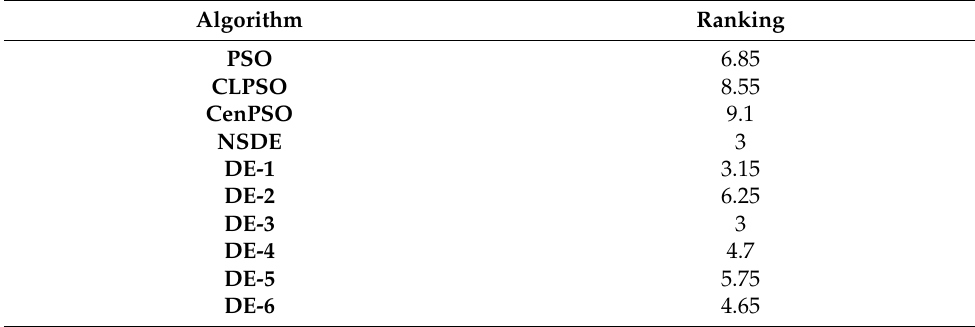
Table 14. Average rankings of the ten algorithms obtained by Friedman test for NP = 30.